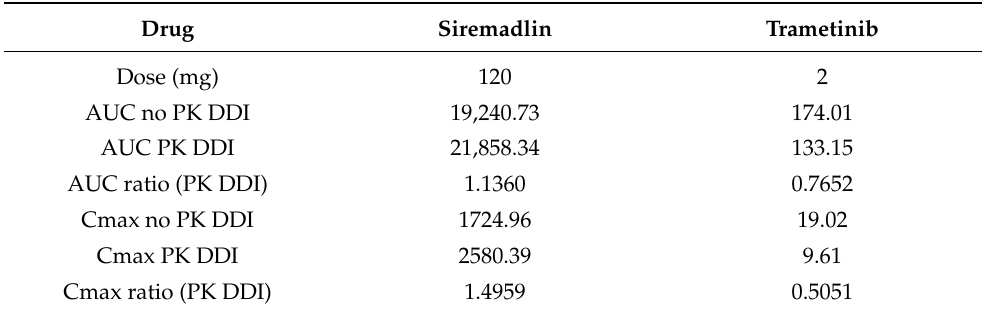
Table 4. Comparison of predicted key PK parameters (AUC 0–24 h and C max ) with and without PK interaction for population representative for siremadlin and trametinib at the 120 and 2 mg doses (with an initial tumour size of 6.4